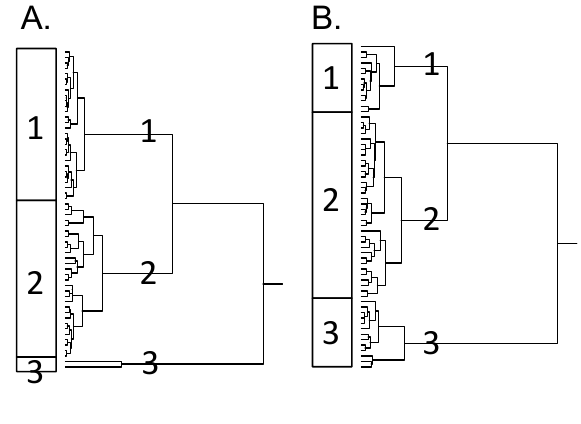
Figure 3. Dendrograms obtained by hierarchical cluster analysis of log ( A ) α -boswellic acid and ( B ) β -boswellic acid of 60 cancer cell lines. The dendrograms were obtained by clustering using the WARD